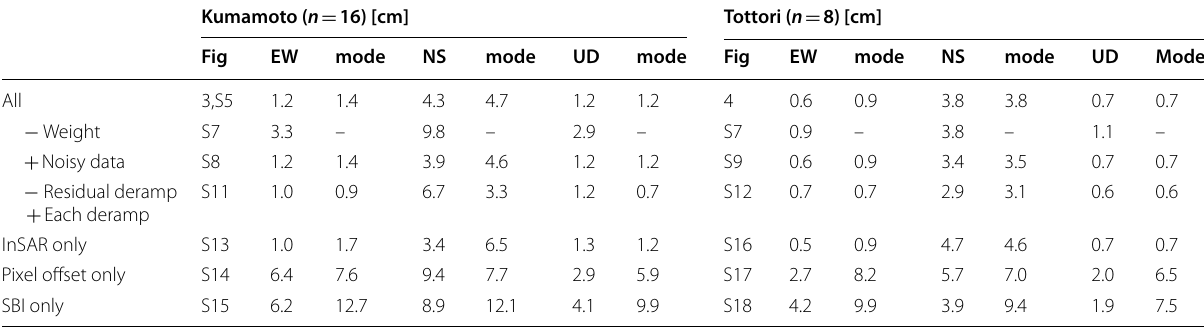
Table 2 Standard deviations of the difference between SAR- and GNSS-derived 3D deformation and modes of SAR-derived standard